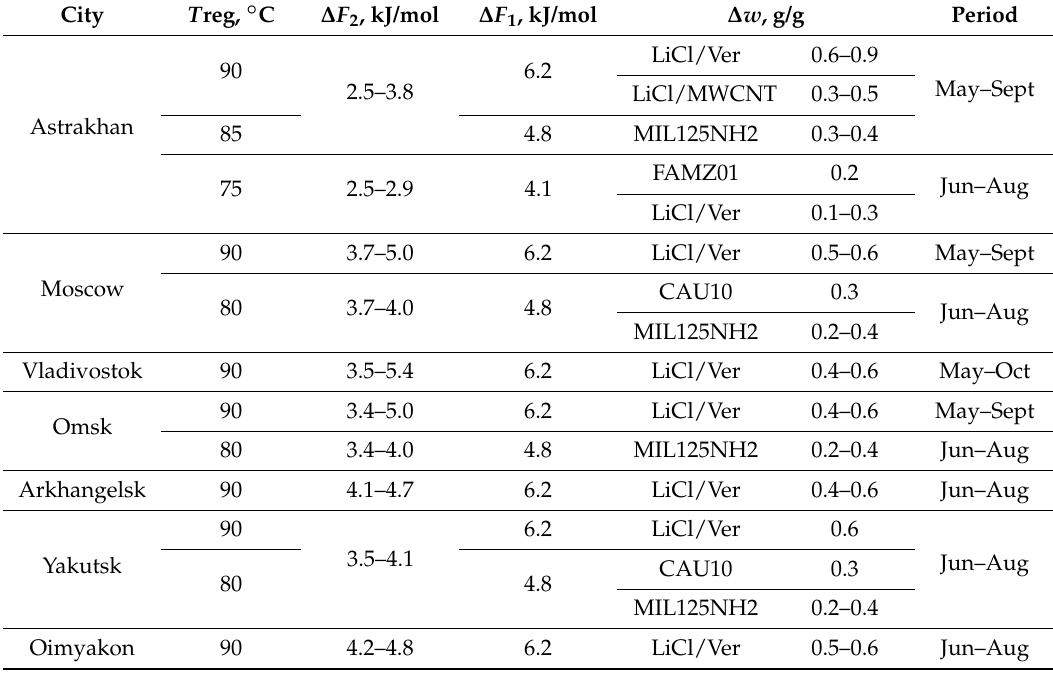
Table 2. The boundary conditions of the heating cycles, the promising adsorbents, and the amount of exchanged